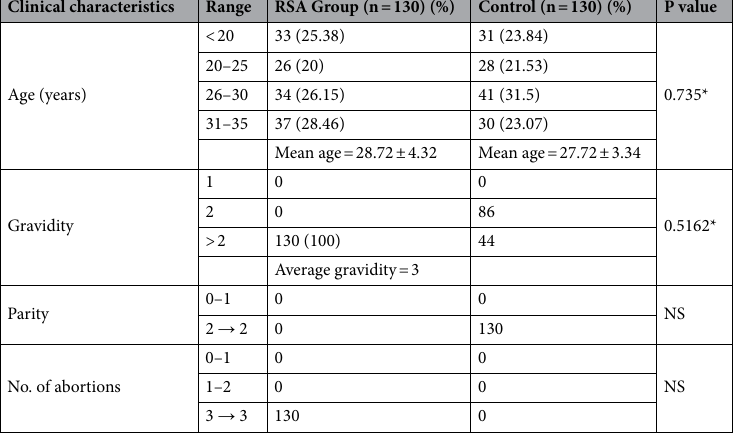
Table 1. Clinical characteristics of aborters and control patients. RSA Recurrent spontaneous abortion, NS non-significant. *Statistically